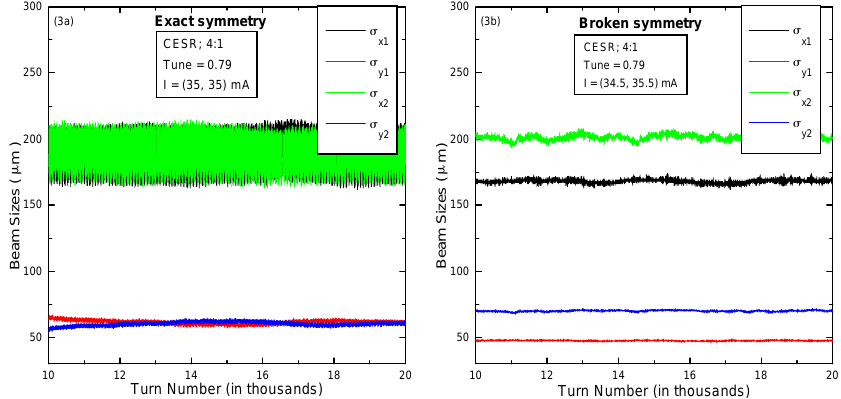
FIG. 3. (Color) For a symmetric collider with CESR-like parameters, plots of beam size vs turn number for (a) exact symmetry with a current of 35 mA in both beams and (b) broken symmetry, with unequal beam currents of 34.5 and 35.5 mA. Note that once the symmetry is broken the equilibrium solution changes from a period- n solution to the more ubiquitous flip-flop